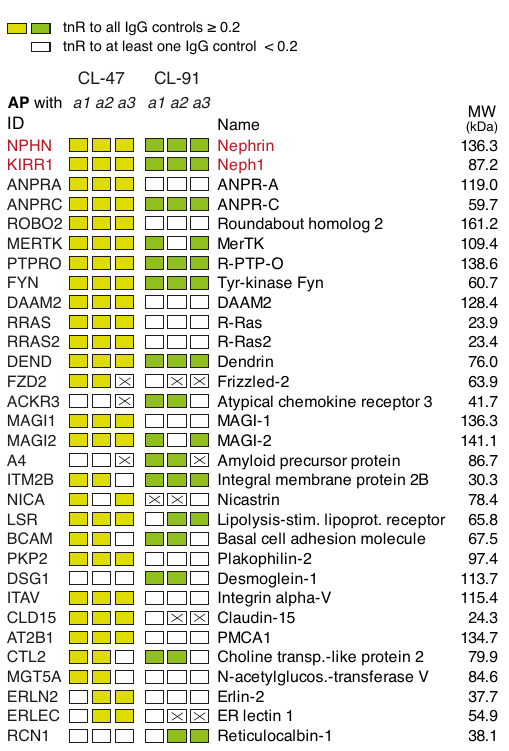
against the indicated proteins. Apparent molecular mass (native PAGE, 1st dimen- sion) and molecular weight (denaturing SDS-PAGE, 2nd dimension) are indicated; gel separations were repeated twice with similar results. Note incorporation of all threeSDcoreconstituentsintohigh-molecular-masscomplexesof~2MDa. D Table summarizingtheresultsofthe fi nallyannotatedconstituentsoftheNephrin/Neph1 interactomeinallsixAPswiththeindicatedABs(SupplementaryFig.2;ABa3refers to anti-Neph1 a1). Each column illustrates the results of the indicated target AP controlled by three target-unrelated APs. Color-coding symbolizing evaluation by target-normalizedratios(tnR)asfollows:yellow/green:tnRagainstalltheecontrols >0.2, white: at least one tnR below the threshold of 0.2, crossed: protein was not identi fi ed in the respective target AP. ID refers to the Swiss-Prot entry of the respective protein. MW of all proteins is indicated on the